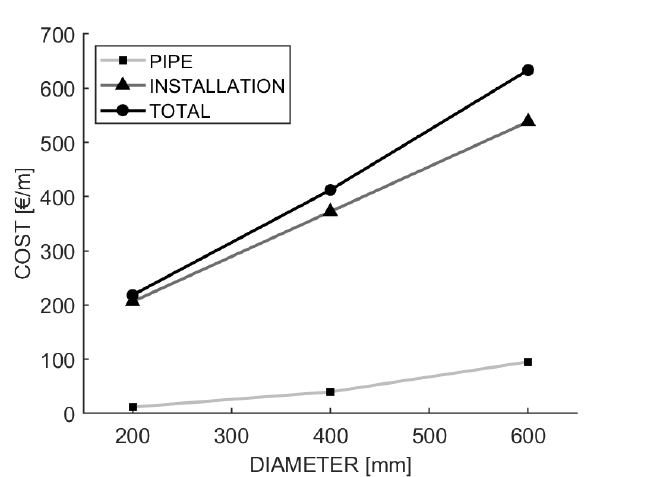
Figure 3. Cost composition of the total pipe installation cost per meter in dependence on the